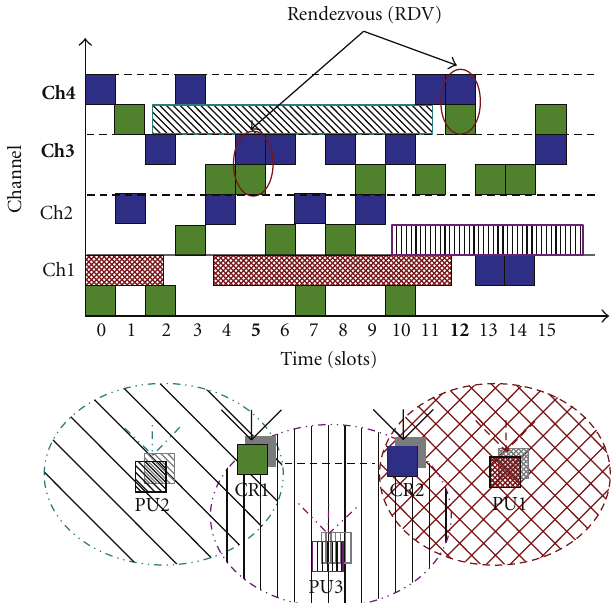
Figure 1: Blind date, rendezvous problem in